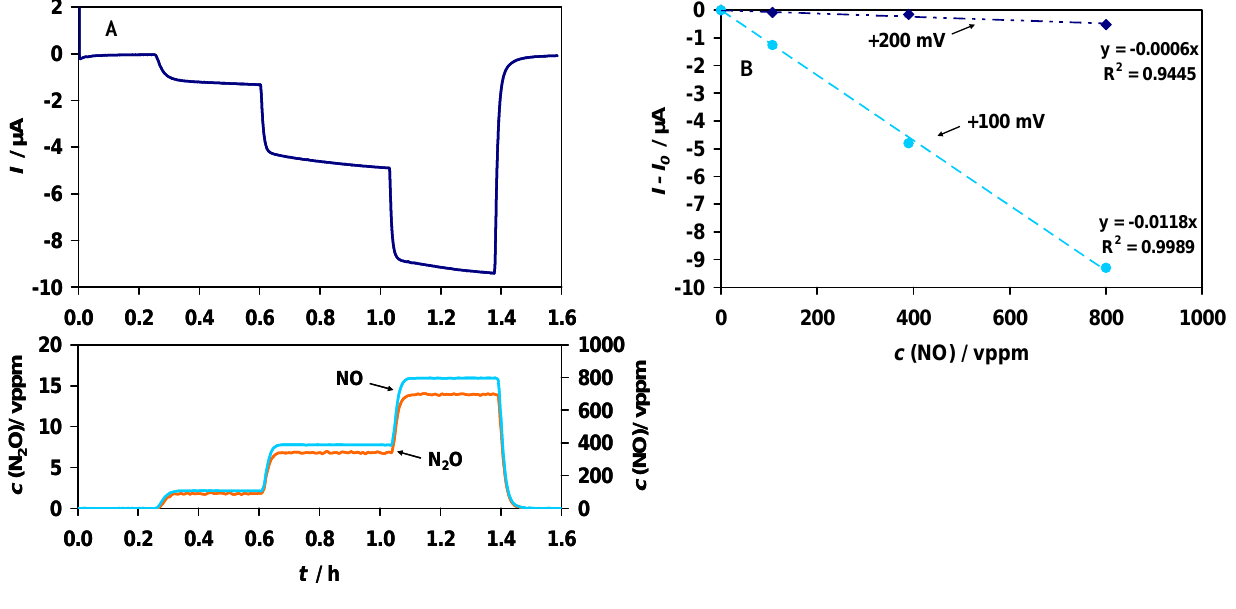
Figure 11. A) Top: Amperometric sensor signal of the “bio”sensor set-up to NO (0 - 800 vppm) at +100 mV vs. Ag/AgCl at a graphite gauze working electrode. The sensor contained neither enzyme FDH, nor NAD + , nor mediator PT. Bottom: Test cycle concentrations of NO (right y-axis) and N O concentrations (left y-axis), which were 2 detected downstream the sensor via FTIR. B) Comparison of the response curve characteristic to NO at +100 mV and +200 mV vs.